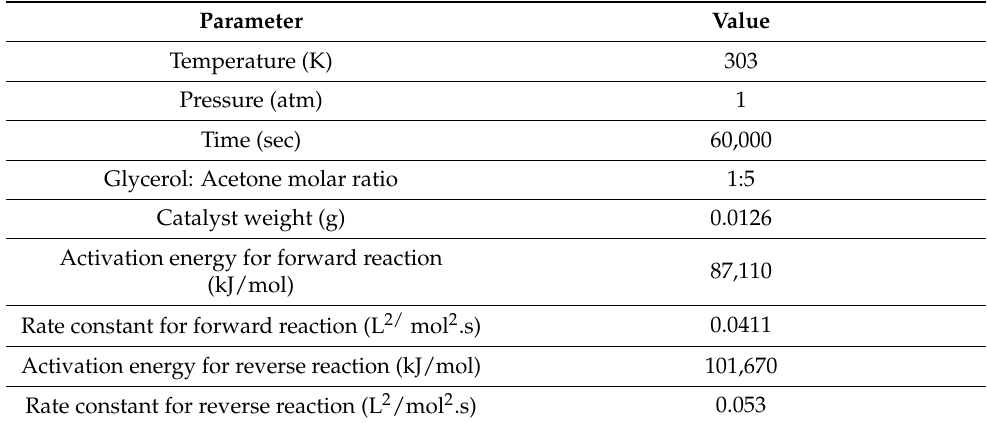
Table 1. Referenced input parameters for Aspen Plus simulation taken from the literature.